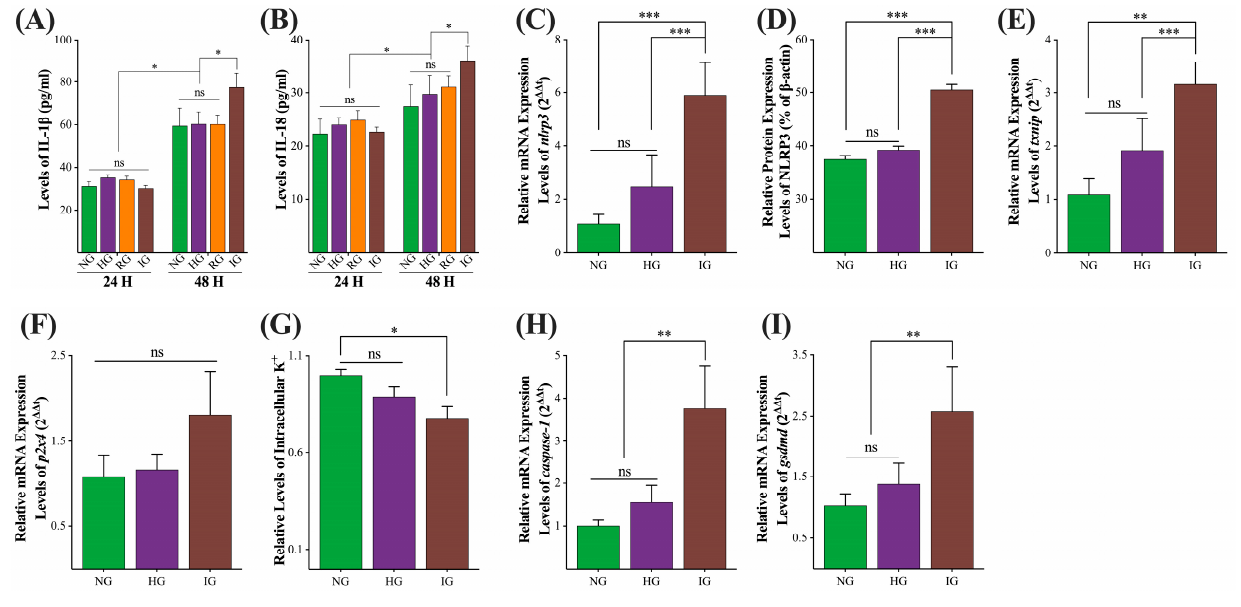
Figure 4. The effects of abnormal glucose on the nlrp3 / caspase-1 / gsdmd pyroptosis pathway. ( A , B ) The levels of pro-inflammatory cytokines IL-18 and IL-1 β in the supernatant of each group; ( C , E – I ) the relative mRNA expression levels of nlrp3 , txnip , p2x4 , caspase-1 , and gsdmd genes in each group; ( D ) the relative protein levels of NLRP3 protein in each group; ( G ) the levels of intracellular K + in each group. All experiments were repeated 3 times, and the data were presented using mean ± SD. Two-tailed t-test; *, p < 0.05; **, p < 0.01; ***, p < 0.001; ns, non-significant.